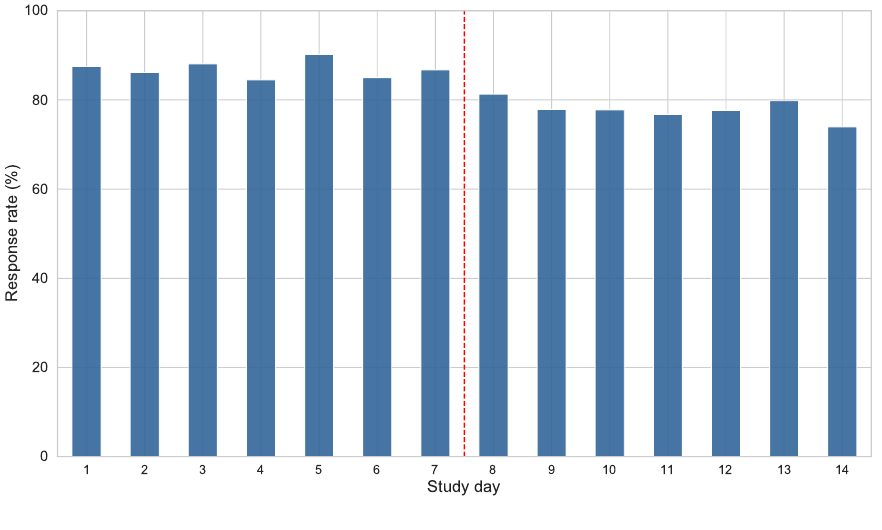
Figure 8. Overall response rate registered per day of study. The red dashed vertical line splits the graphic in the two weeks of the